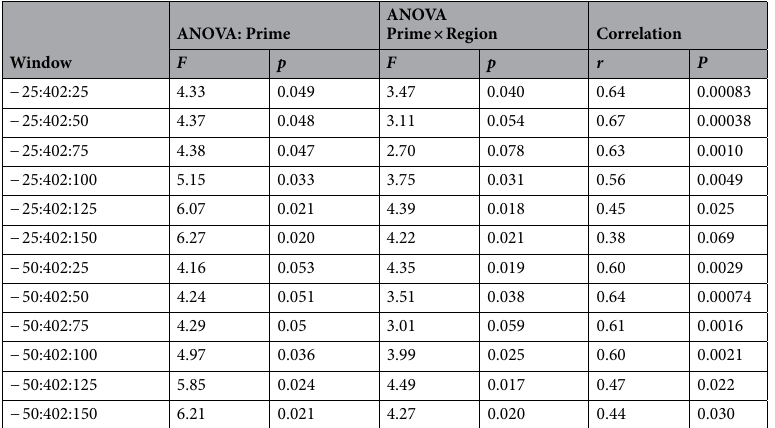
Table 2. ANOVA results using different time windows for the main effect of Prime Type and the interaction between Prime Type and Region, and correlations between the size of the priming effect with consistent and inconsistent words primed by related and unrelated primes. The three numbers in the comparison represent the window duration before the minimum N400 value, the minimum N400 value (402 ms), and the window duration after the minimum N400